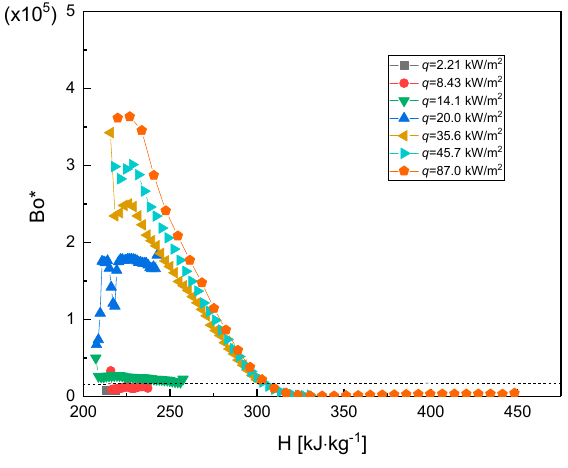
Figure 12. Mixed convection in supercritical carbon dioxide.